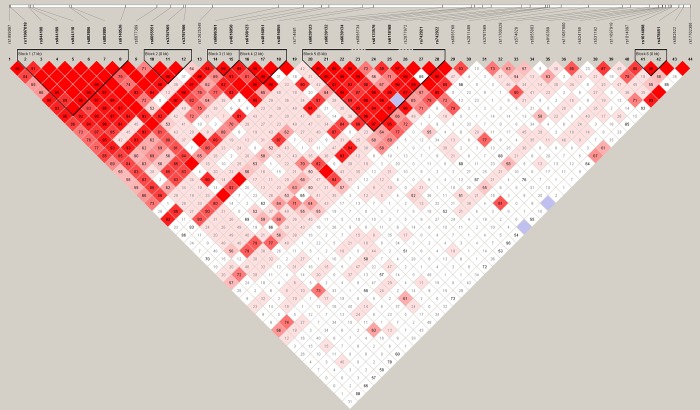
LD structure of ANGPT4 in the DN dataset.